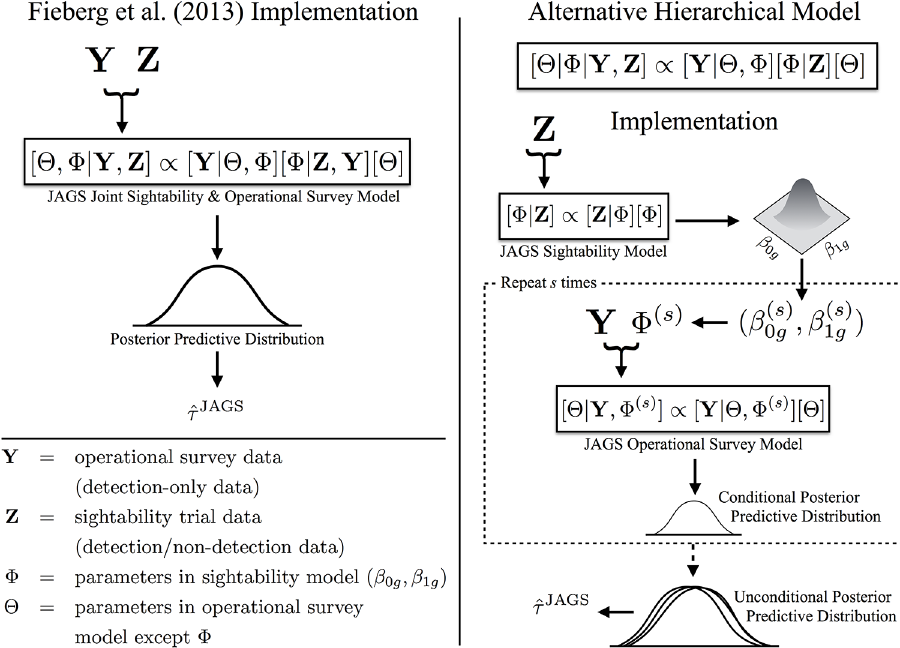
Fig 2. Model comparison diagram. Diagram comparing the original joint hierarchical model of Fieberg et al . [8] and the alternative hierarchical model implemented using the two-step approach. The left shows the original, Fieberg et al . [8] approach, which jointly models the detection-only data ( Y ) and the detection/non-detection data ( Z ) together. The right shows the alternative, hierarchical model, with parameters estimated by: (1) generating MCMC samples that converge in distribution to [ F | Z ] / [ Z | F ][ F ];this is accomplished by fitting the sightability model to Z only; (2) sampling from [ F | Z ] s times to get F ð s Þ ¼ ð b ð s Þ ; b ð s Þ Þ , which we subsequently treat as “data” in step [3]; and (3) 0 g 1 g generating MCMC samples that converge in distribution to [ Θ | Y , F ( s ) ] / [ Y | Θ , F ( s ) ][ Θ ]. Finally, we pool all posteriors from [3] together to create a pooled, unconditional posterior predictive distribution for estimating abundance ( ^ t JAGS ).